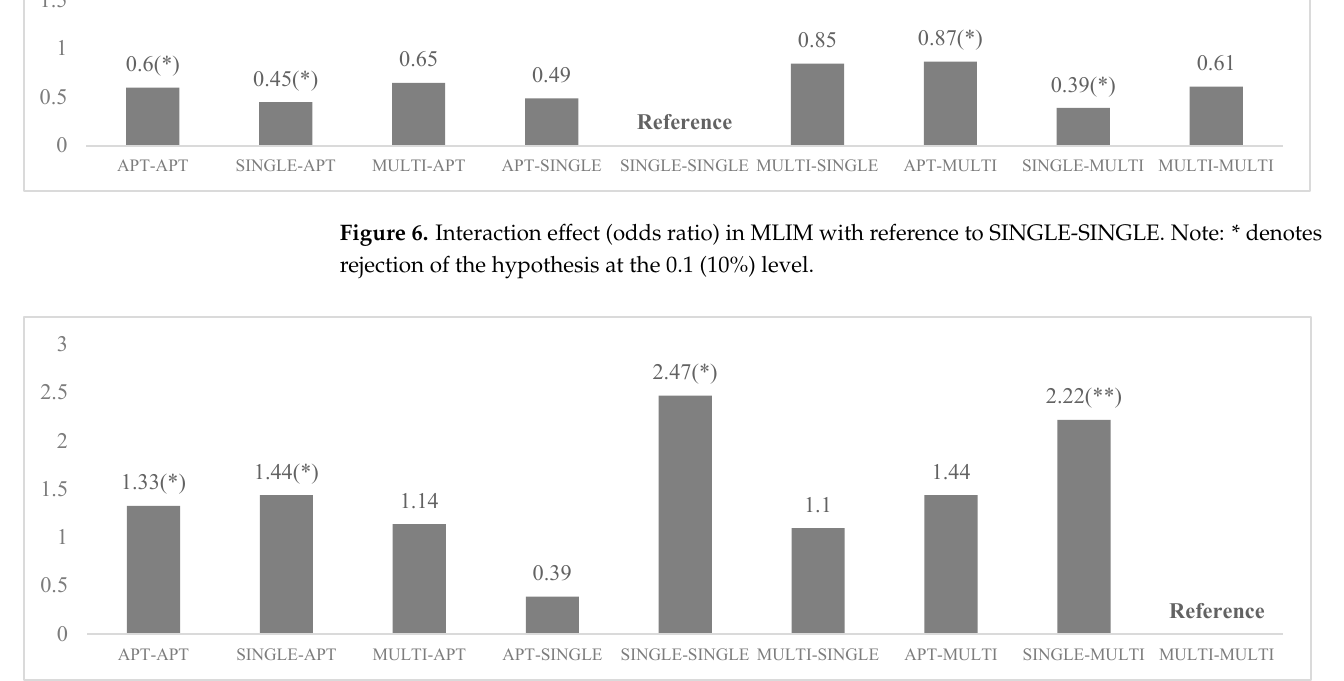
Figure 7. Interaction effect (odds ratio) in MLIM with reference to MULTI-MULTI. Note: **, * denote Figure 7 . Interaction effect (odds ratio) in MLIM with reference to MULTI-MULTI. rejection of the hypothesis at the 0.05 (5%) and 0.01 (1%) levels,